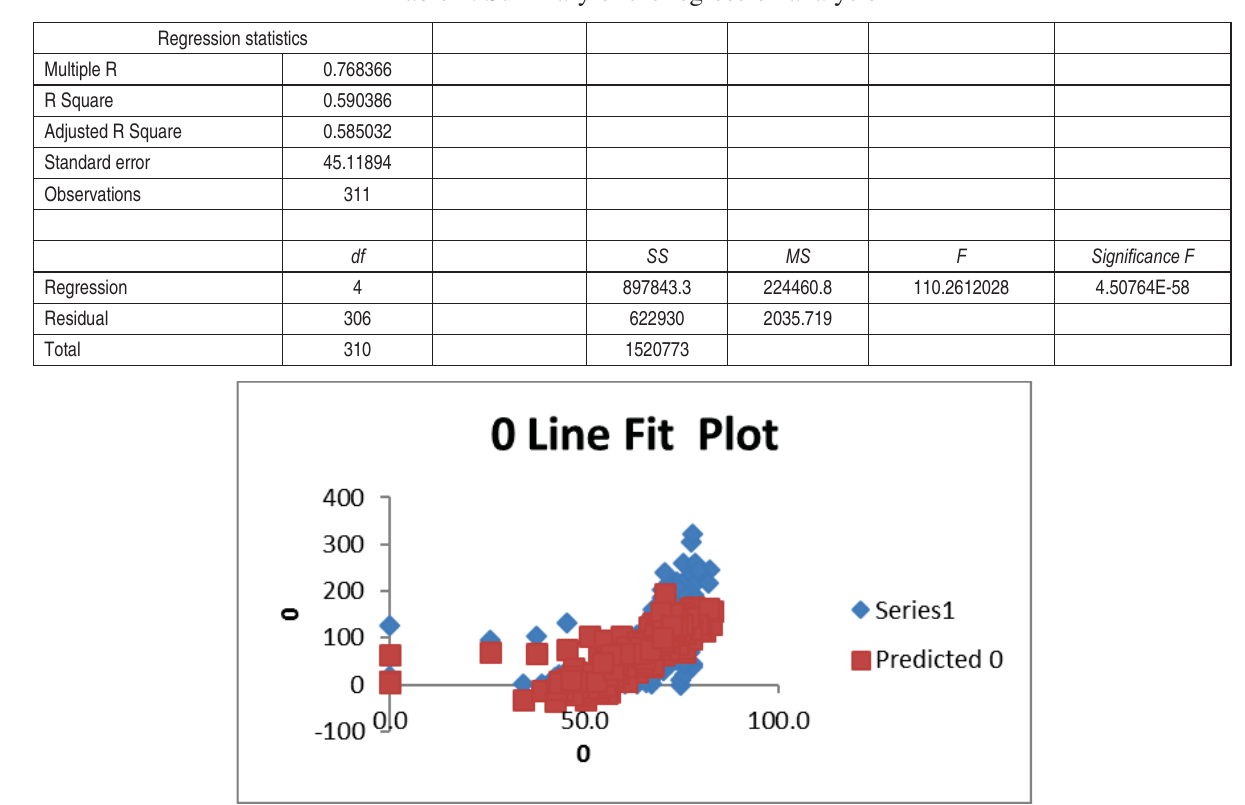
Table 1. Summary of the regression analysis